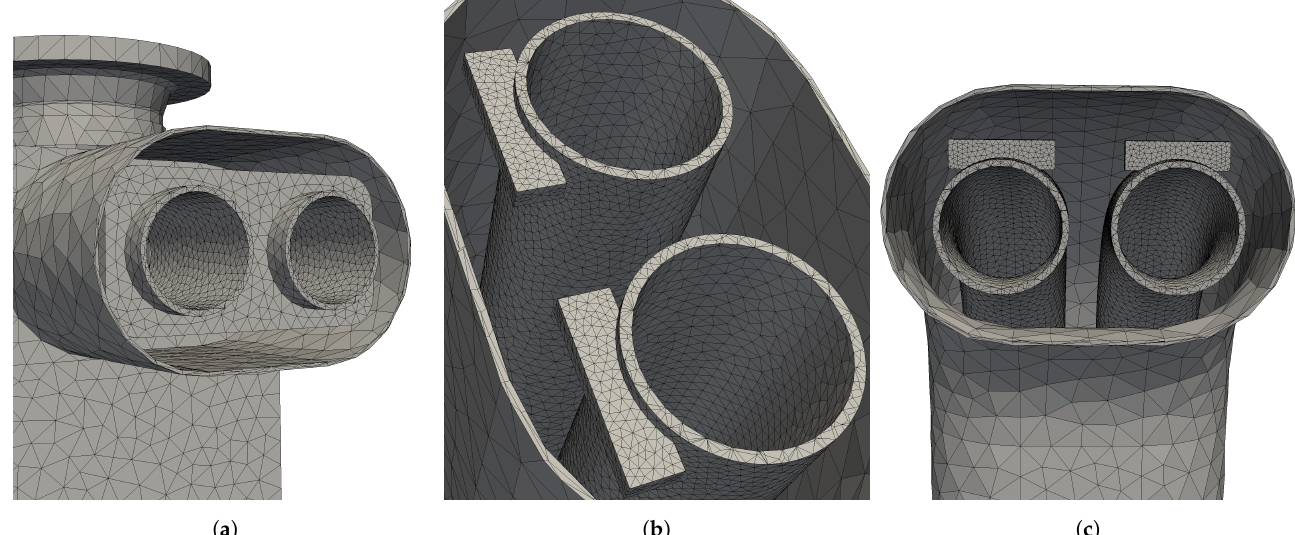
Figure 7. Connection of the critical mesh regions. ( a ) Node plate—measuring pipes. ( b ) Sensor—measuring pipes. ( c ) Exciter—measuring